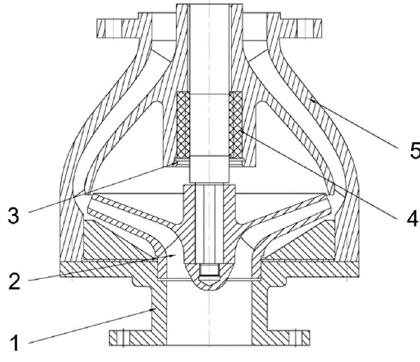
Figure 2. Hydraulic components structure of the MSP; 1. inlet; 2. impeller; 3. elastic collar; 4. guide bearing; 5. vane diffuser.